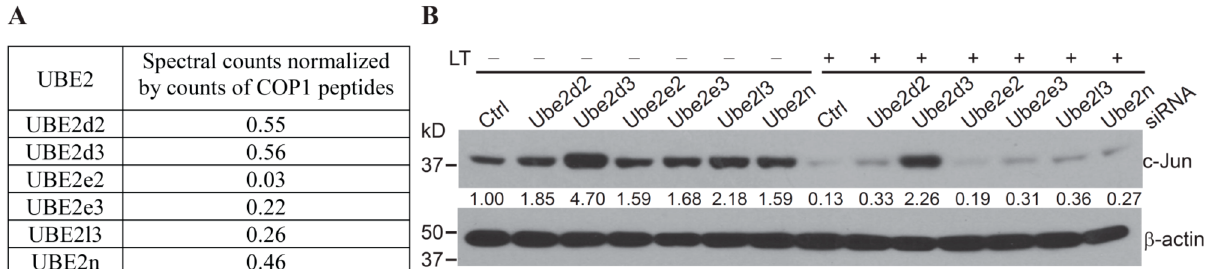
4 of 11 Figure 2. Protein phosphatases PP1 and PP2A promote c-Jun degradation following U0126 treatment. ( A ) Hepa1c1c7 cells were transfected with the indicated siRNA targeting PP1 and/or PP2A. Two days following transfection, the cells were cultured with or without U0126 for 1 h and then extracted with NuPAGE LDS sample buffer. The expression levels of the indicated proteins in the cell lysates were assessed by Western blotting. Knockdowns of target proteins by siRNAs were